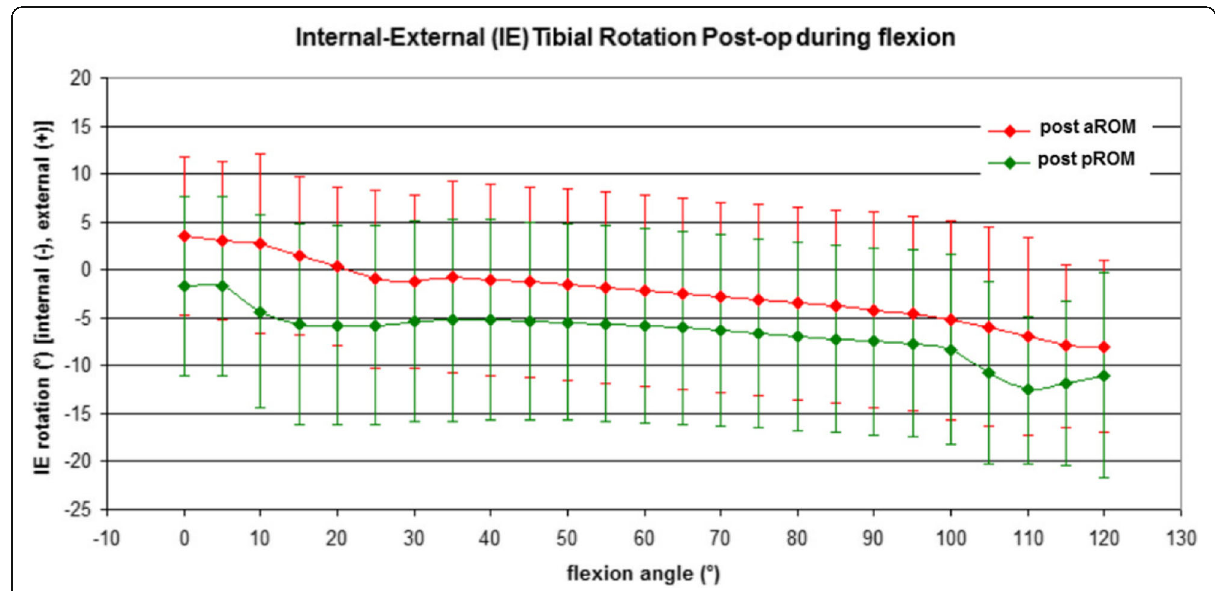
Fig. 4 Post-operative active and passive internal-external rotation of the femur with respect to the